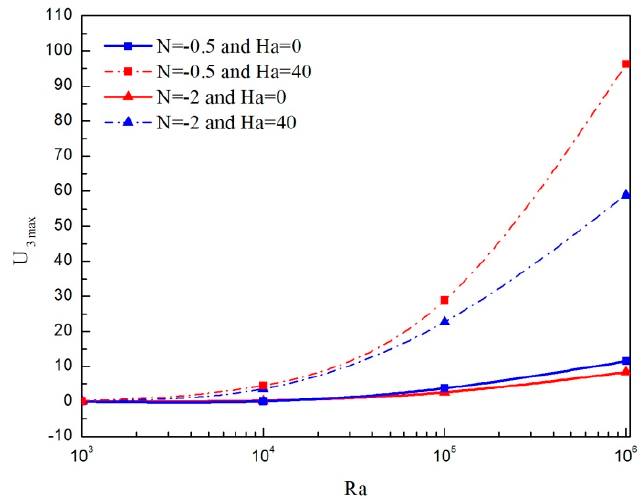
Figure 12. Variation of U 3max according to the Rayleigh number in the plane X = 0.5 without (Ha = 0) and with magnetic field (Ha = 40) for φ = 4% and K = 1 for N = − 0.5 and N = − 2.